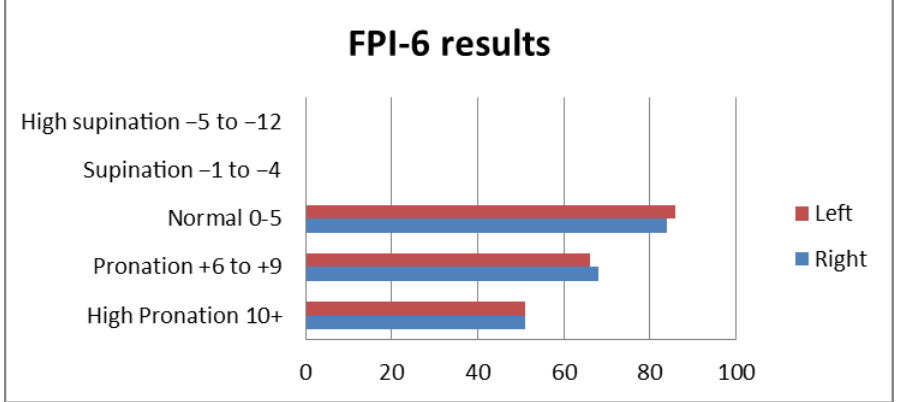
Figure 1. Histogram of all FPI-6 analyses. Right foot pronation with a score of FPI ≥ +6 was observed in 58.6% (119, n = 203) of children, normal foot position of FPI < 6 was observed in 41.3% (84, n = 203), and supination of FPI ≥ − 1 was not detected in any participants. For the left foot, a normal position of FPI < 6 was observed in 42.3% (86, n = 203) of children, pronation was observed in 57.6% (117, n = 203), and supination of FPI ≥ − 1 was not detected (Figure 2).